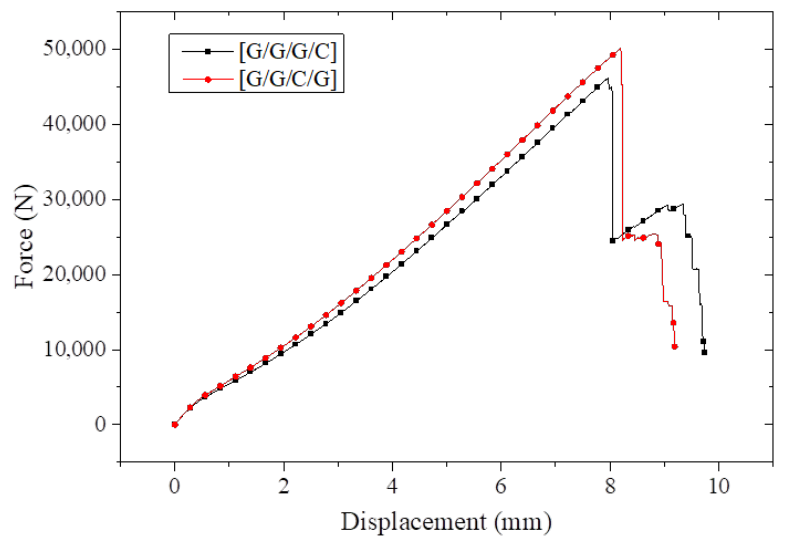
Figure 10. Tensile force–displacement curves of interlayer composites with the hybrid ratio C:G = 1:3.